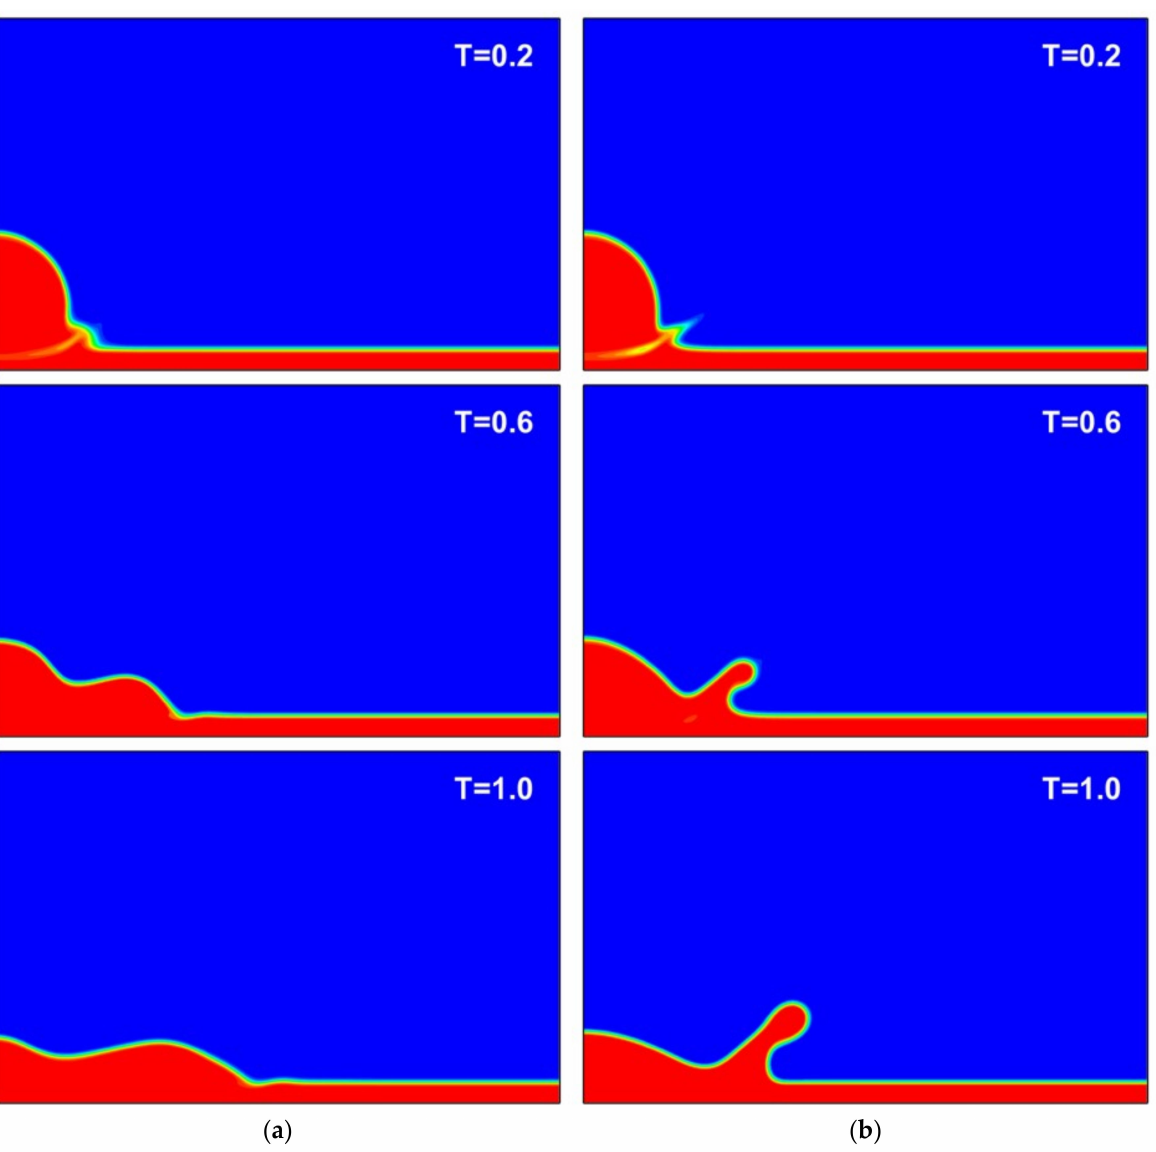
Figure 24. Development of the interface with Re = 800 and H = 15 with the present method: ( a ) We = 10, ( b ) We =